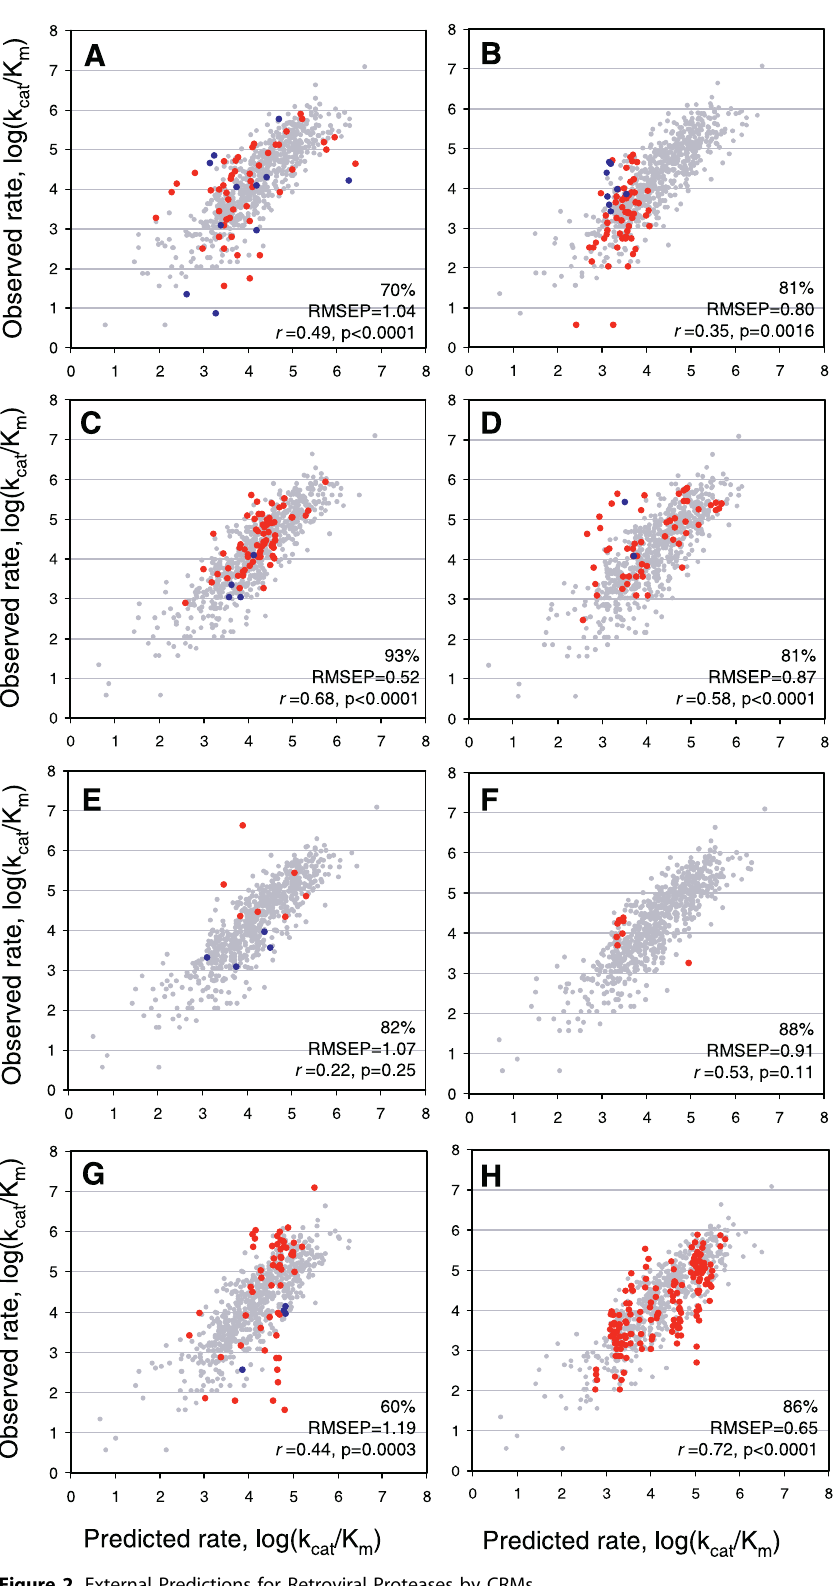
Figure 2. External Predictions for Retroviral Proteases by CRMs Each panel represents the predictions of a model created on the data collected herein (Table S1), but excluded all data for the proteases of one retroviral strain, one at a time, and uses the model to predict the excluded data. Blue bullets correspond to prediction of cleavage activity for new proteases and new substrates (i.e., the cases in which neither the protease nor the peptide was represented in the dataset used in creation of the model). Red bullets correspond to prediction of the cleavage rates for the new proteases only (i.e., the cases in which the peptide, but not the protease, was represented in the dataset used for model creation). Gray dots represent the observed versus computed cleavage rates for each of the respective models (i.e., the data used for model creation). PLoS Computational Biology |